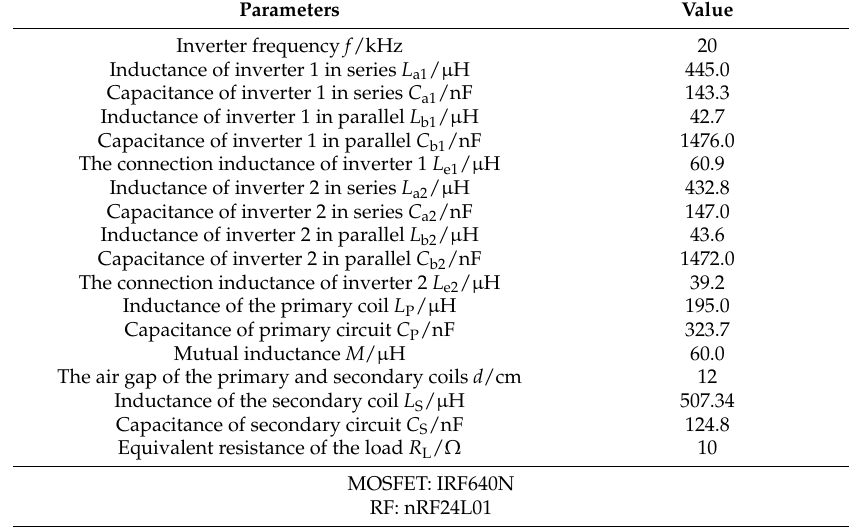
Table 2. Design specifications and circuit parameters of inductive power transfer (IPT) prototype.